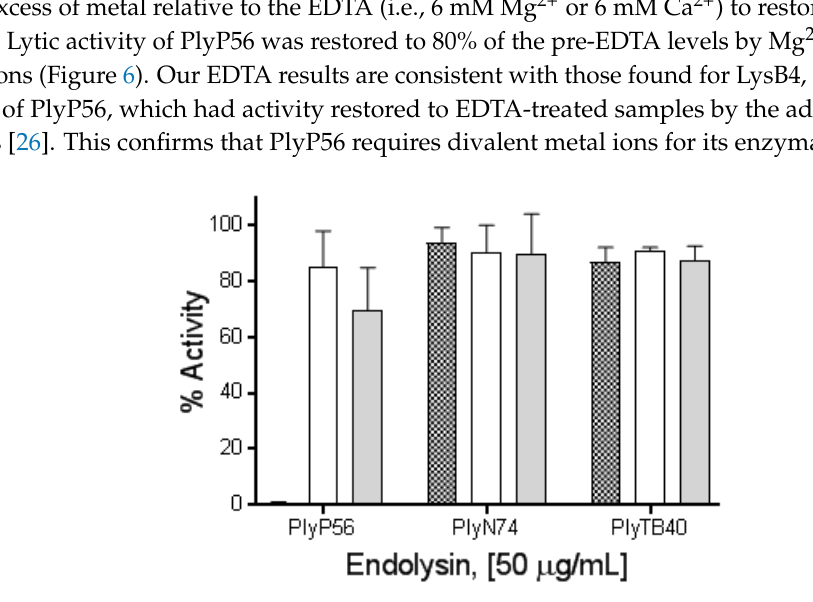
Figure 6. Metal binding properties of PlyP56, PlyN74, and PlyTB40. The influence of divalent cations on PlyP56, PlyN74, and PlyTB40 lytic activity against stationary phase B. cereus ATCC 4342 was assayed via turbidity reduction assay. Mean values from three independent experiments run in triplicate are represented as the percentage residual lytic activity relative to untreated endolysins. Endolysins treated with EDTA (checker bars), and subsequently recovered via dialysis with additions of divalent ions, Mg 2+ (white bars), Ca 2+ (grey bars) are